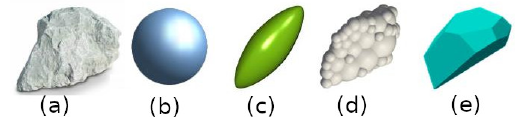
Figure 2. (a) System size and shearing conditions (b) initial un- consolidated simulation state.